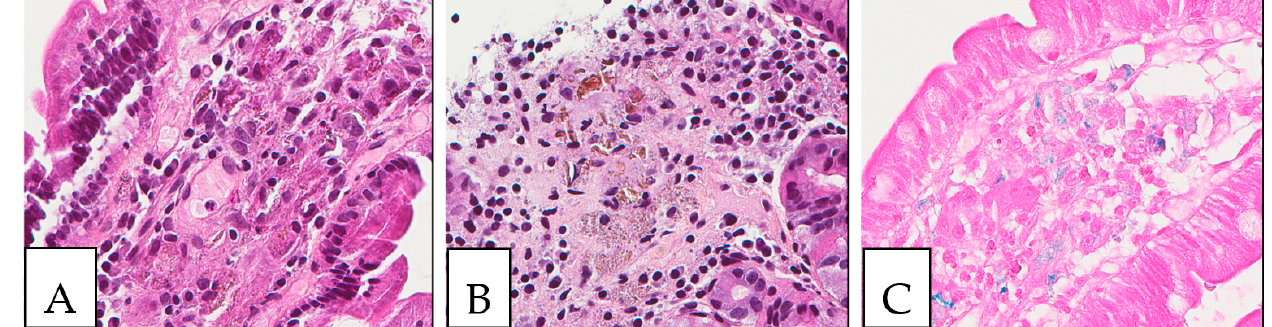
Figure 8. Iron deposits in the gastrointestinal mucosa. Histiocytes with cytoplasmic crystalloid-like pink/brown material in the duodenum ( A ) and the stomach ( B ). ( C ) Positive iron stain (Perl’s) in the duodenum. A 74-year-old male patient with known multiple myeloma presented with diarrhea, and an endoscopy was performed.